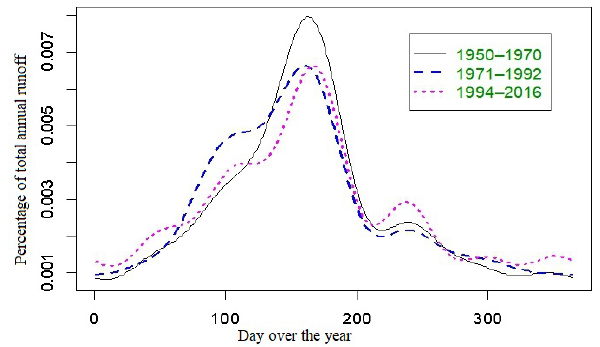
Figure 1. The lower reaches of the Minjiang River.